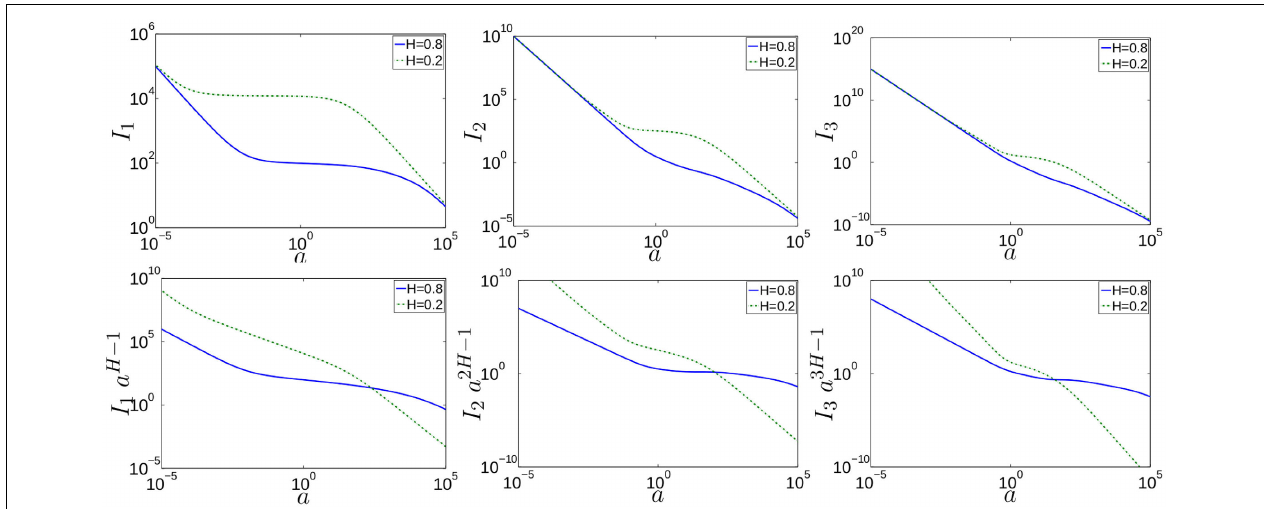
FIGURE 2 | Top: Numerical computation of integrals I k ( a , L ) defined in Equation (20) for two different Hurst exponents (plain line: H = 0 . 8, dashed line: H = 0 . 2). The size is L = 2 19 and the integral has been sample averaged over twenty realizations. The regime of interest, where non-trivial scaling will occur, is in the region of intermediate values of a . As